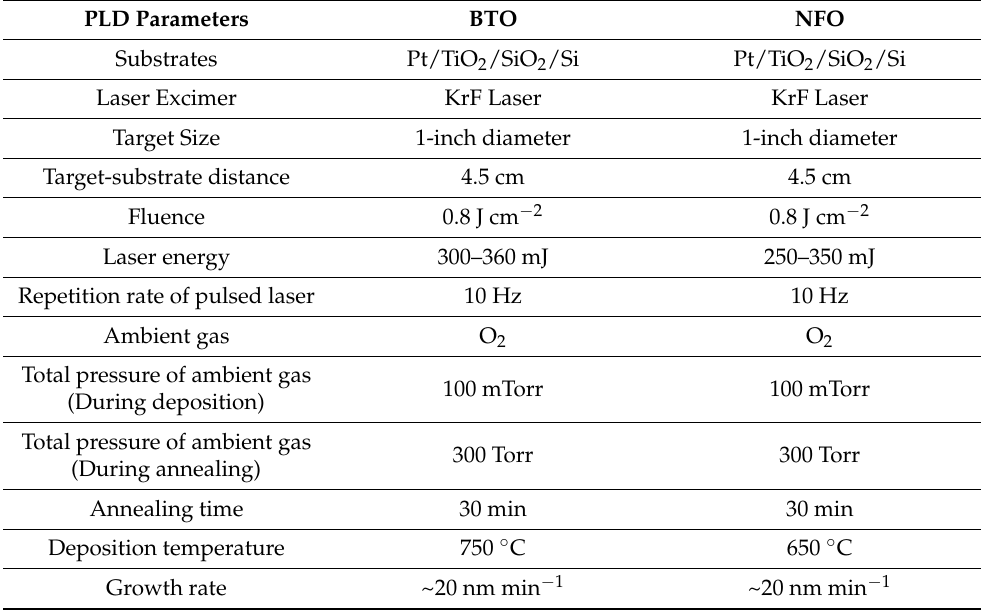
Table 1. Pulsed Laser Deposition (PLD) parameters of BTO/NFO/BTO thin films. PLD